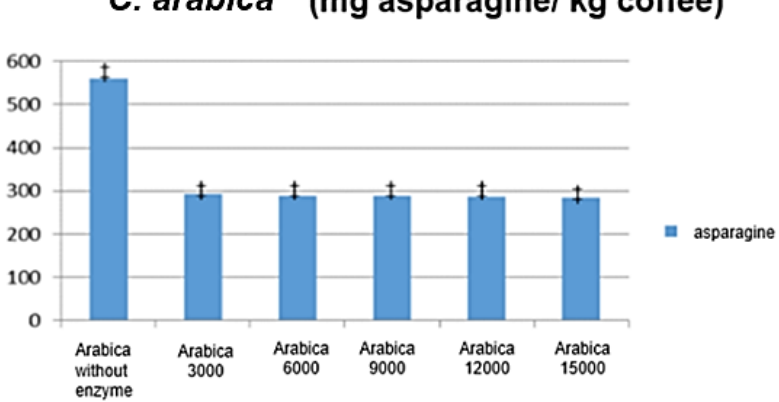
Figure 3. Asparagine reduction in C. Arabica depending on different enzyme concentrations.